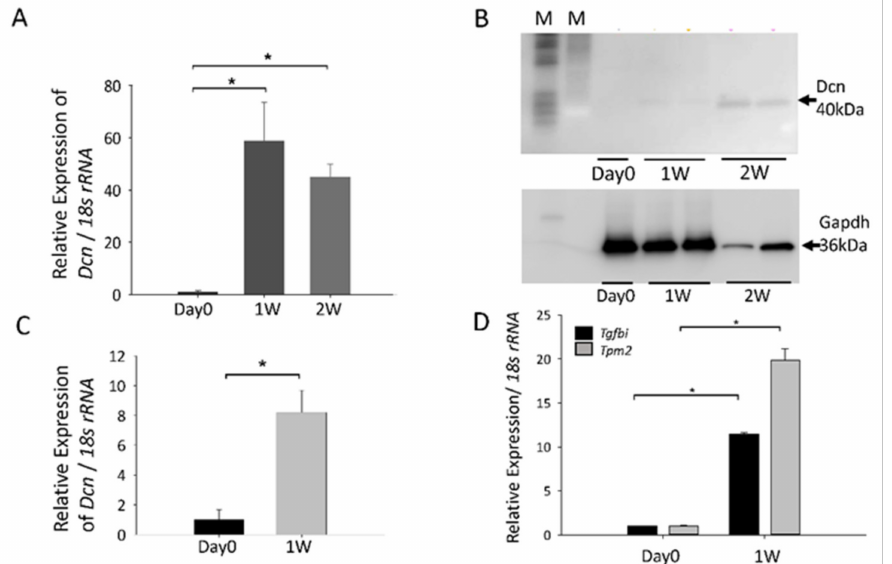
Figure 2. RT-qPCR validation of Dcn and Tpm2 expression in rat or mouse posterior capsule opacifi- cation (PCO). ( A ) Expression of Dcn mRNA in rat PCO samples 1 and 2 weeks (W) after extracapsular clear lens extraction (ECLE) was compared to that on day 0 (* p < 0.0003) ( B ) Expression of DCN protein in mouse PCO samples 1 and 2 weeks after ECLE compared to that on day 0 (* p < 0.0025) ( C ) Expression of Dcn mRNA in mouse PCO samples 1 week after mouse PCO onset was compared to that on day 0 (* p < 0.0025) ( D ) Relative expression of Tgfbi and Tpm2 mRNAs 1 week after mouse PCO onset was compared to that on day 0 (* p < 0.000001). Data were from three experiments and were reported as mean ± S.D ( n =